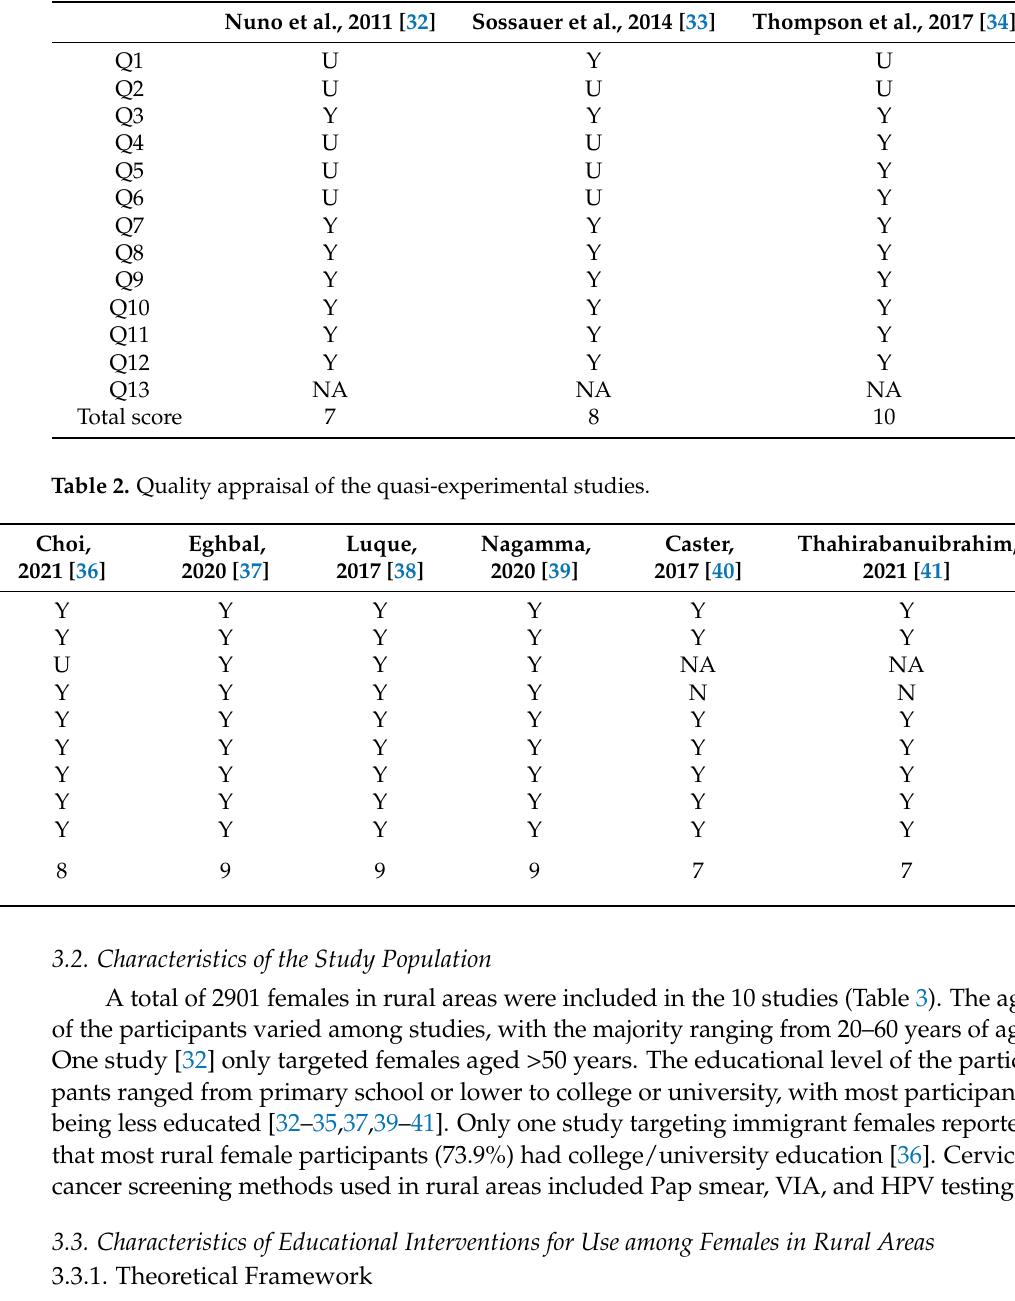
Table 1. Quality appraisal of the RCTs.